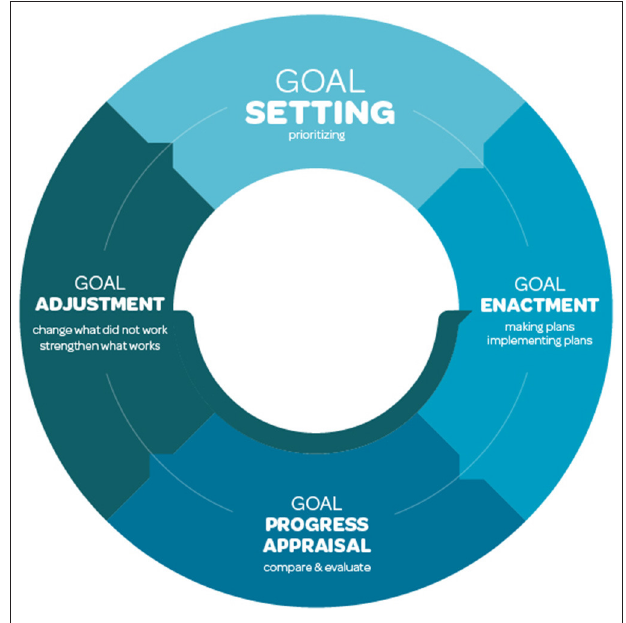
FIGURE 1 | Self-control approach of sexualized drug use